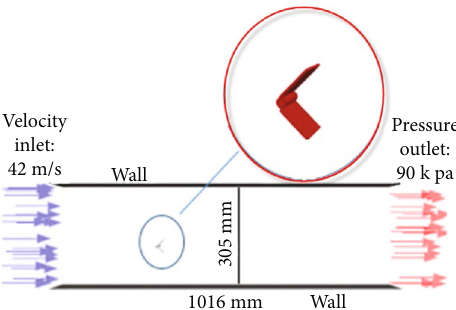
Figure 4: Boundary conditions and computational domain schematic illustrated for single